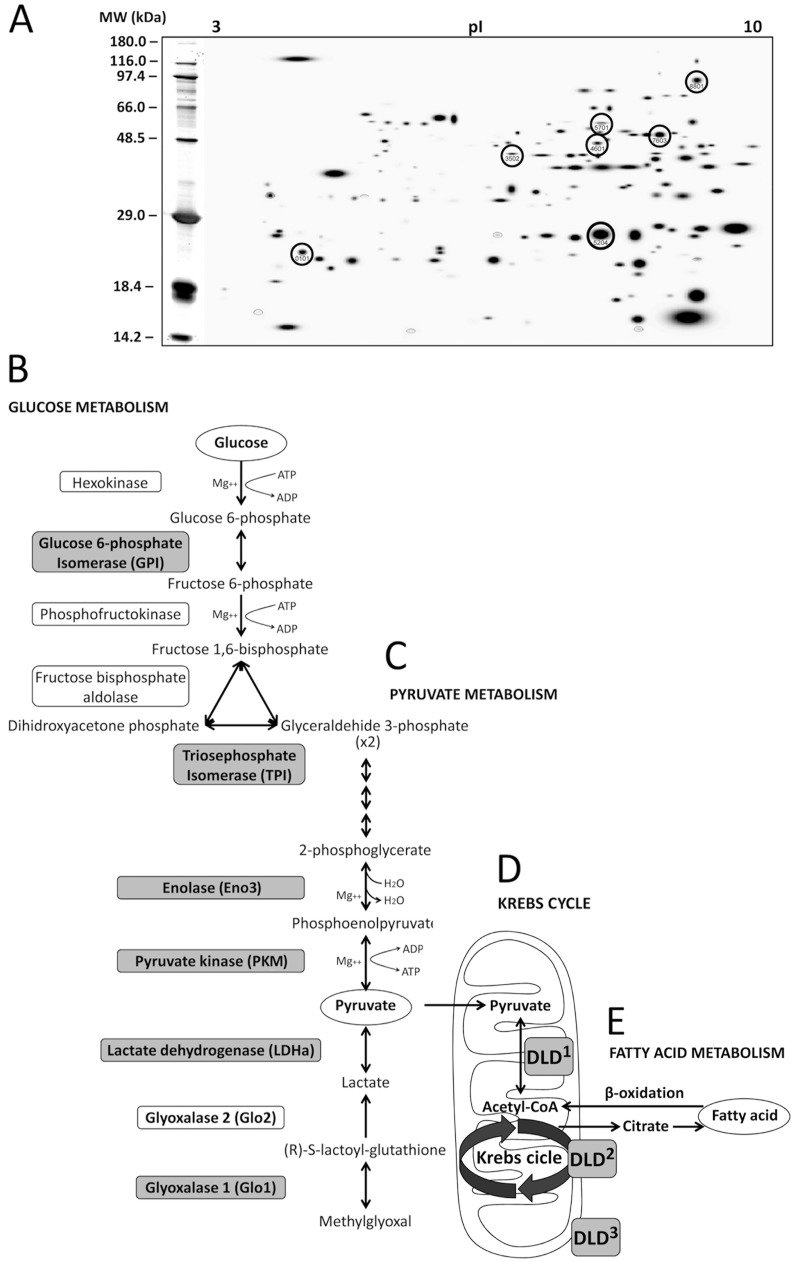
Protein identification and characterization in muscle of DIO rats treated with AM251.Seven proteins in the abdominal muscle of STD, HFD and HCD-fed rats treated with AM251 were identified by using 2-dimensional (2D) electrophoresis and MALDI-TOF/LC-ESI trap mass spectrometry. A) A representative 2D polyacrylamide gel showing the selected spots. B-D) Scheme of the glucose and pyruvate pathways and Krebs cycle showing the step reaction of the seven enzymes identified. E) Fatty acid metabolism. Dihydrolipoamide dehydrogenase (DLD) is an E3 component with dehydrogenase/diaphorase activity of the mitochondrial pyruvate1/α-ketoglutarate2/branched-chain α-ketoacid3 dehydrogenase complexes.